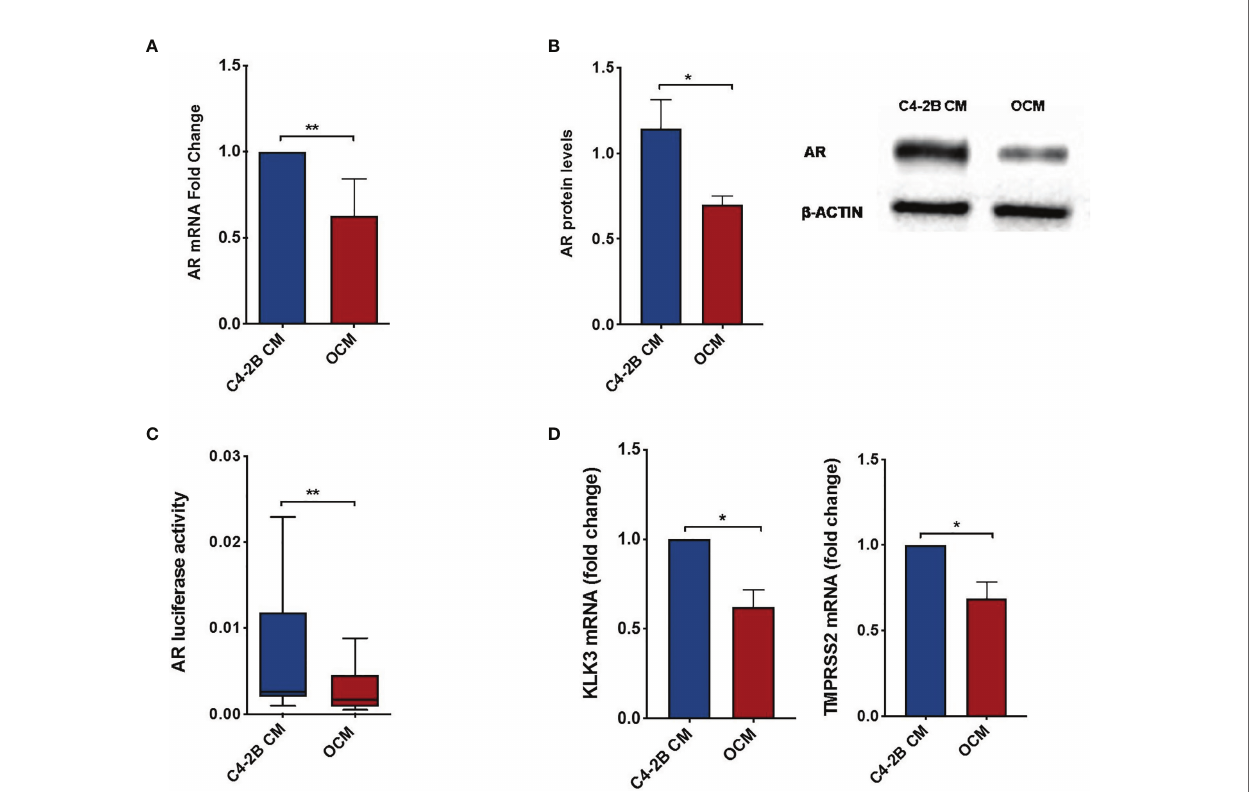
FIGURE 3 | AR and AR-target gene expression in C4-2B FR cells after OCM treatment. (A) AR mRNA levels normalized for the housekeeping b -glucoronidase (GUS- b ). Values are expressed as fold change relative to the control. (B) Representative image and schematic representation of AR protein expression normalized for the housekeeping b -actin. (C) AR activity of C4-2B FR cells measured as fi re fl y luciferase signal normalized with Renilla luciferase signal (housekeeping control). (D) KLK3 and TMPRSS2 mRNA levels were normalized for the housekeeping b -glucoronidase (GUS- b ). Values are expressed as fold change relative to the control.* p < 0.05; ** p <